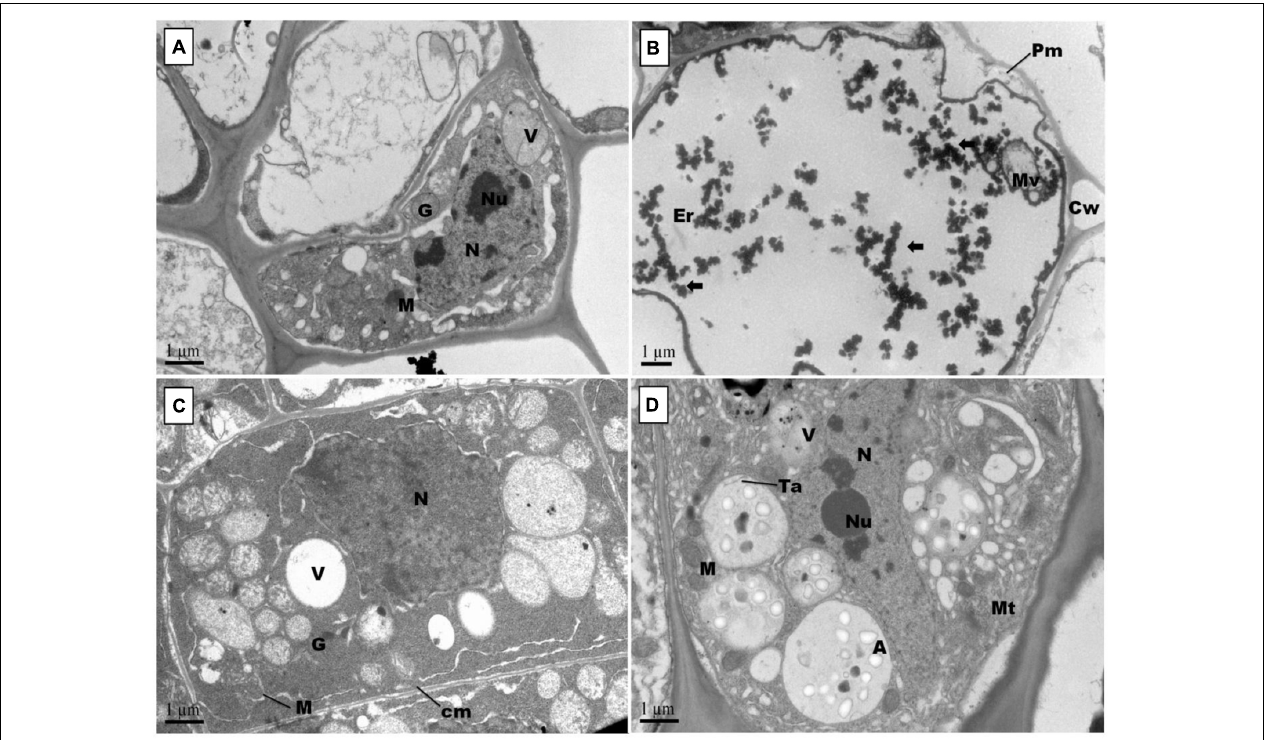
FIGURE 7 | Effect of Pb and GSH on primary root ultrastructure in upland cotton Transmission electron micrographs represent root tips cell morphology of control (A) , 500 µ M Pb (B) , 50 µ M GSH (C) and 500 µ M Pb + 50 µ M GSH (D) in cotton seedlings. Control cells (A) posses cytoplasm embedded with nucleus (N) containing nucleoli (Ne), vacuole (V), Golgi vesicles (G) and several mitochondria (M). In Pb-treated cells (B) , plasma membrane (Pm) was broken and cytoplasm severely damaged. Electron dense particles ( ⇐(cid:72) ) were scattered throughout the cell. GSH (C) induced formation of vacuoles, mitochondria and multivesicular structures. In GSH + Pb (D) , large multivesicular structures contained amyloplasts (A), thylakoids (Ta) and microtubules